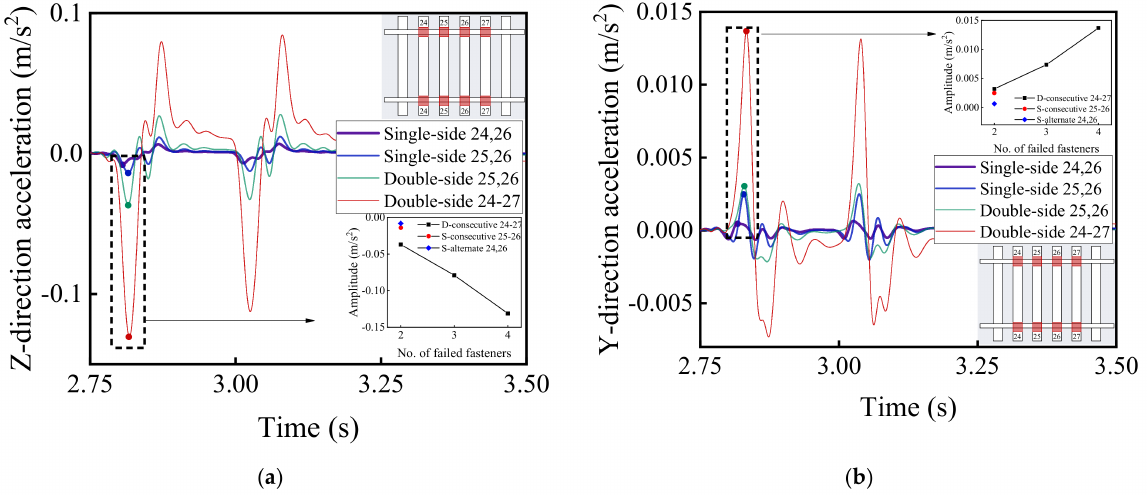
Figure 25. The time-history variations of ( a ) vertical and ( b ) lateral acceleration response of No. 2 railcar body (or the first passenger